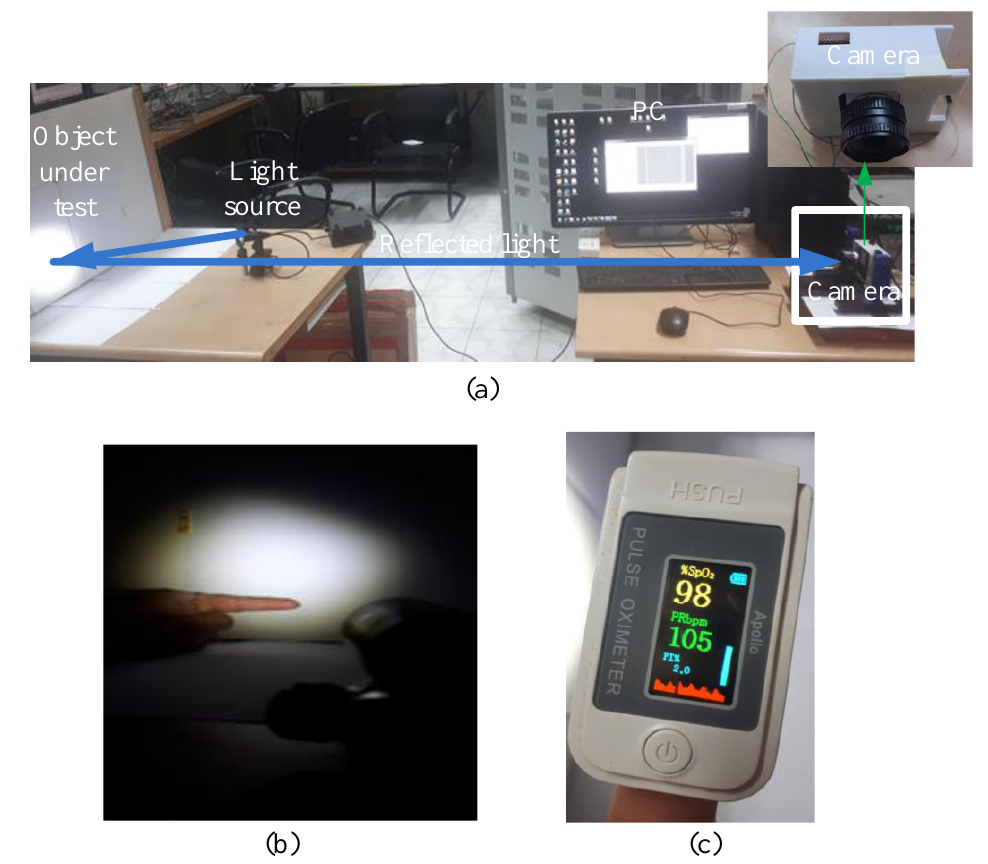
Figure 2. ( a ) The experimental set-up, ( b ) the position at which the image of the fingertip is captured, and ( c ) the commercial oximeter used for